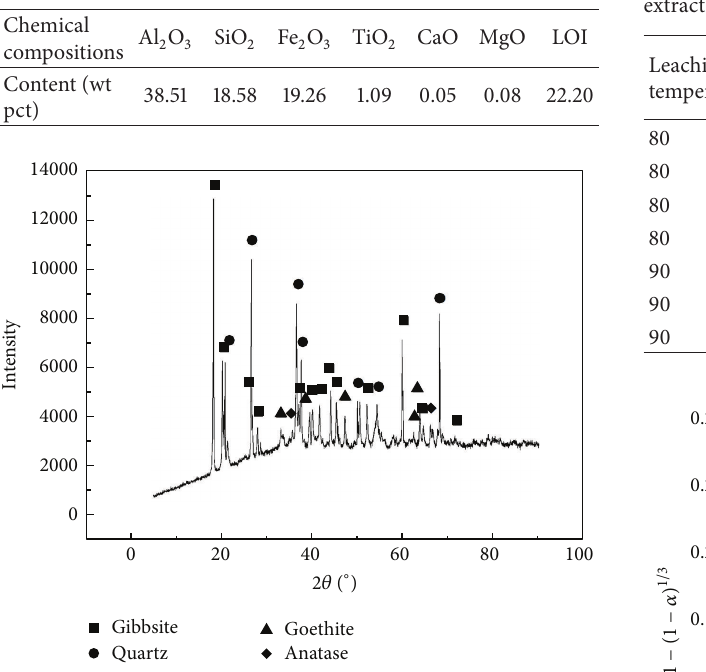
Figure 1: XRD patterns of raw ore.